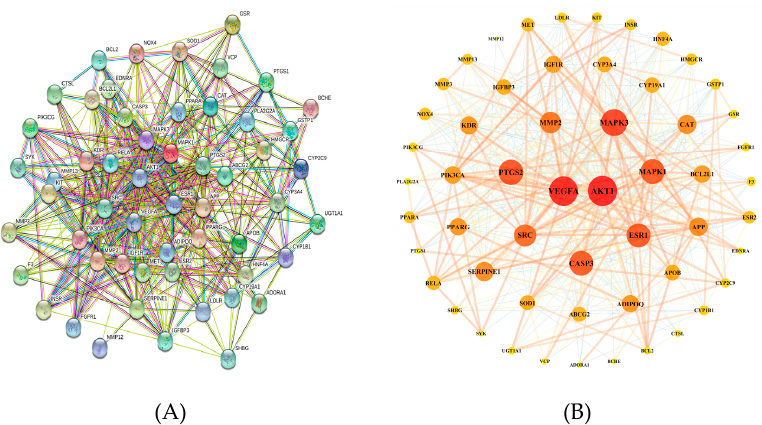
Figure 3. Protein–protein interaction (PPI) network related to naringenin targets-COPD targets (NT-CTs). ( A ) The network in the STRING database. ( B ) The network visualized in Cytoscape software. A high node degree value is represented by a large size and dark color, whereas a low node degree value is represented by a small size and light color. Table 7. The list of 55 core targets ranked by degree value.